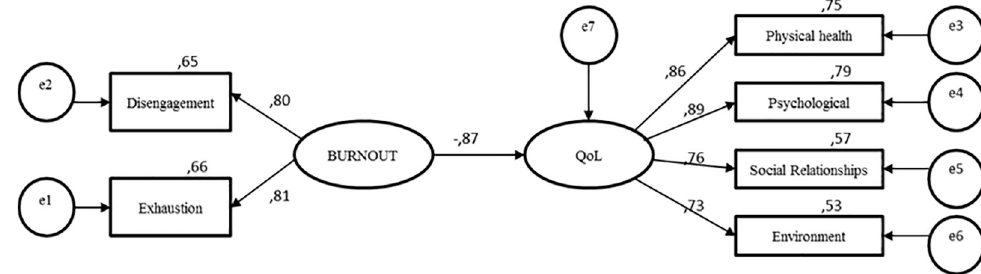
Fig 1. Structural equation modelling: Impact of burnout in faculty members’ quality of life. Parameters: X 2 = 30.962; X 2 /df = 3.84; RMR = 0.012; GFI = 0.972; AGFI = 0.926; CFI = 0.982; RMSEA = 0.091; p < 0,001; df =